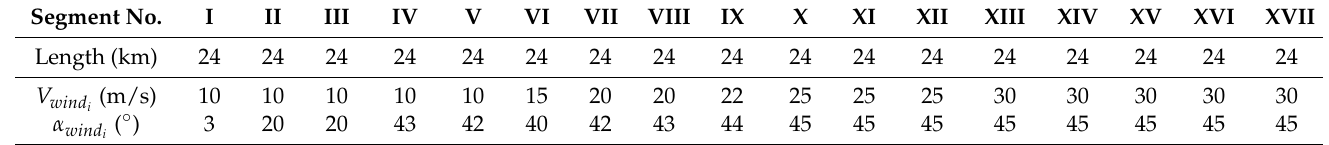
Table 2. Flight conditions along the cruising trajectory at the altitude of 10 km on 6 April 2020. Segment No.